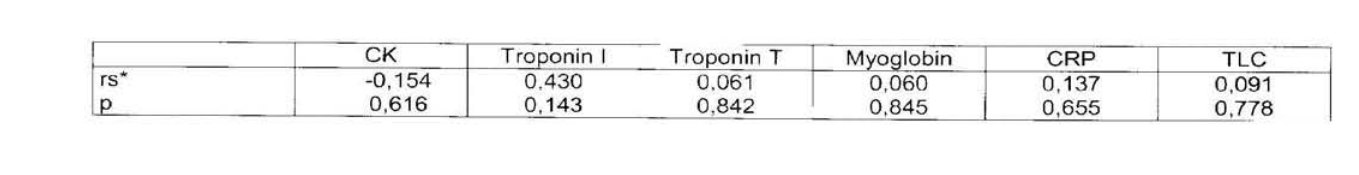
Table 4: Correlations between serum neopterin and parameters of isokinetic dynamometry, ^Spearman's Rank correlation coefficients Abbreviations: Ext = extension; le = left leg; con = concentric work; ecc = eccentric work; ri = right leg; Flex =